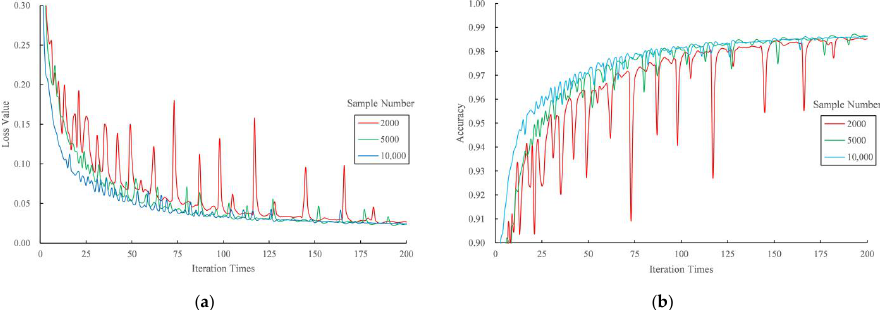
Figure 3. The change curve of training loss value with the iterations times ( a ) and the change curve of training accuracy with the iterations times ( b ) under different sample numbers.